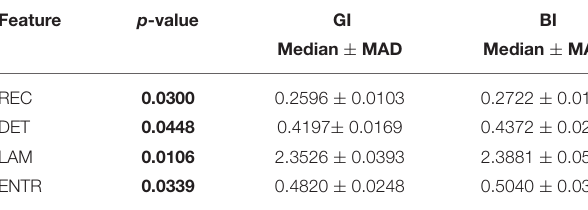
TABLE 3 | Statistical comparison between BI and GI. Feature